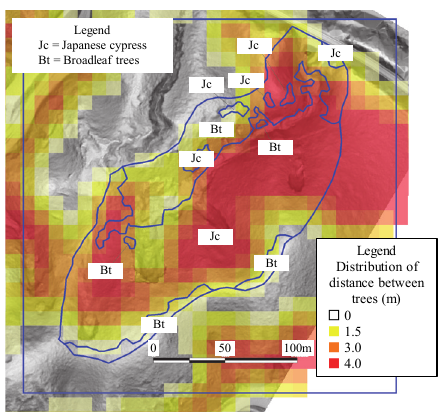
Figure 8. Distribution of distance between trees ( X ) in the watershed